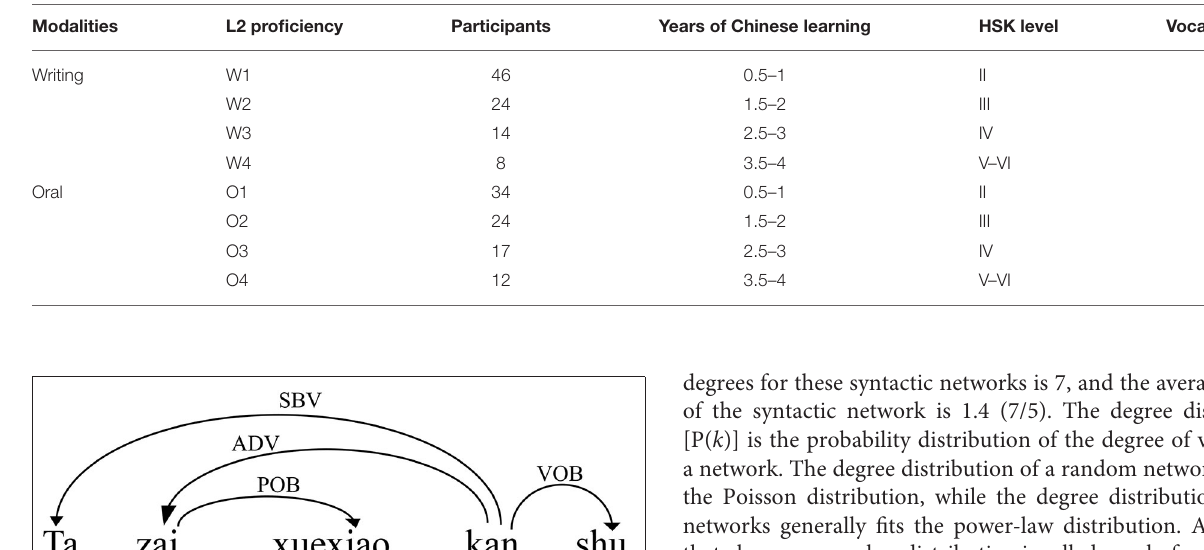
TABLE 1 | Basic data for each corpus.